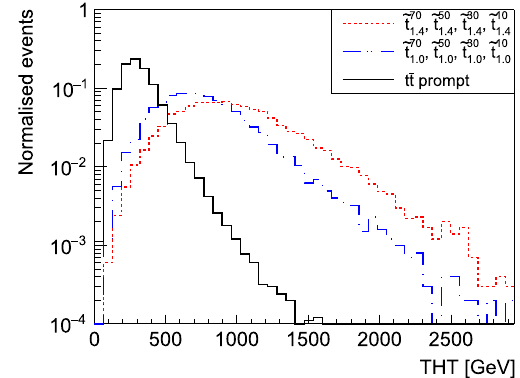
Fig. 50 Transverse impact parameter d 0 distributions for the eight benchmarks for the long-lived stop squark with a magnetic field of B = 3 . 8 T